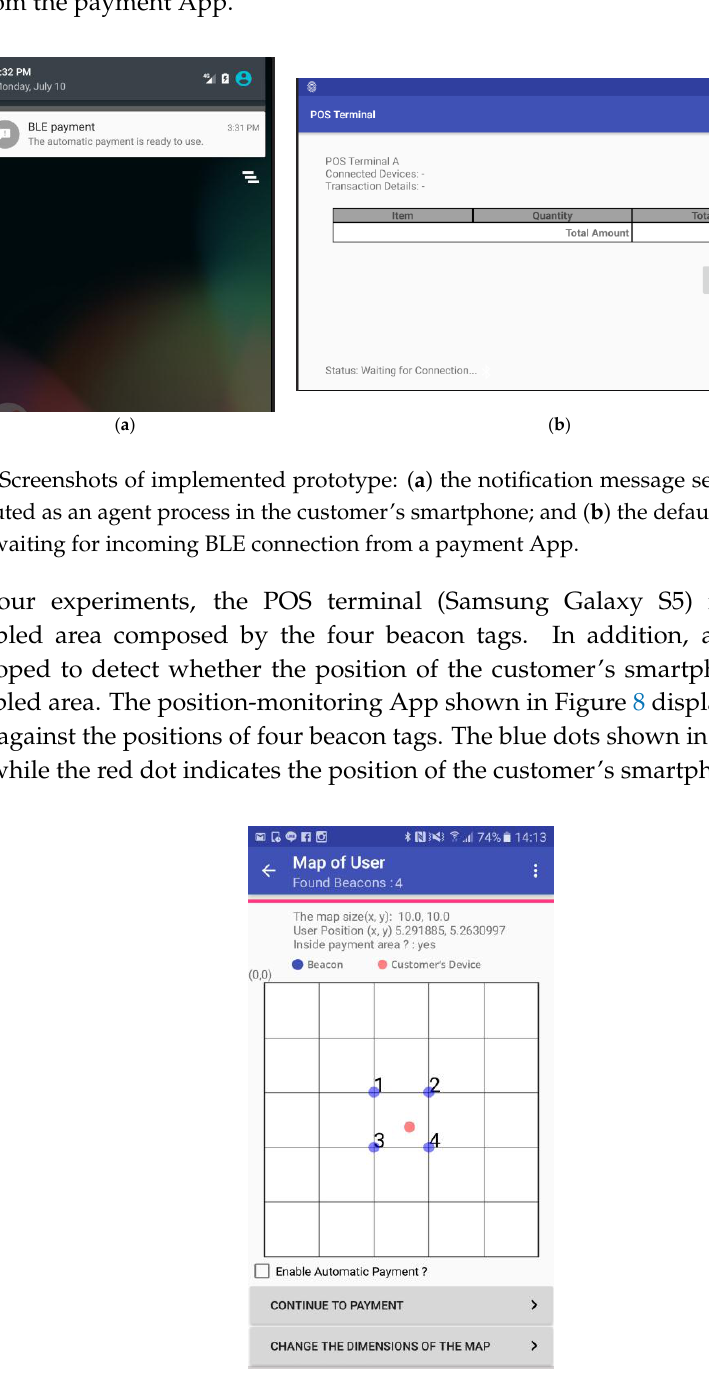
Figure 8. The position-monitoring App shows the current position of the corresponding smartphone in the map of a target payment-enabled area.